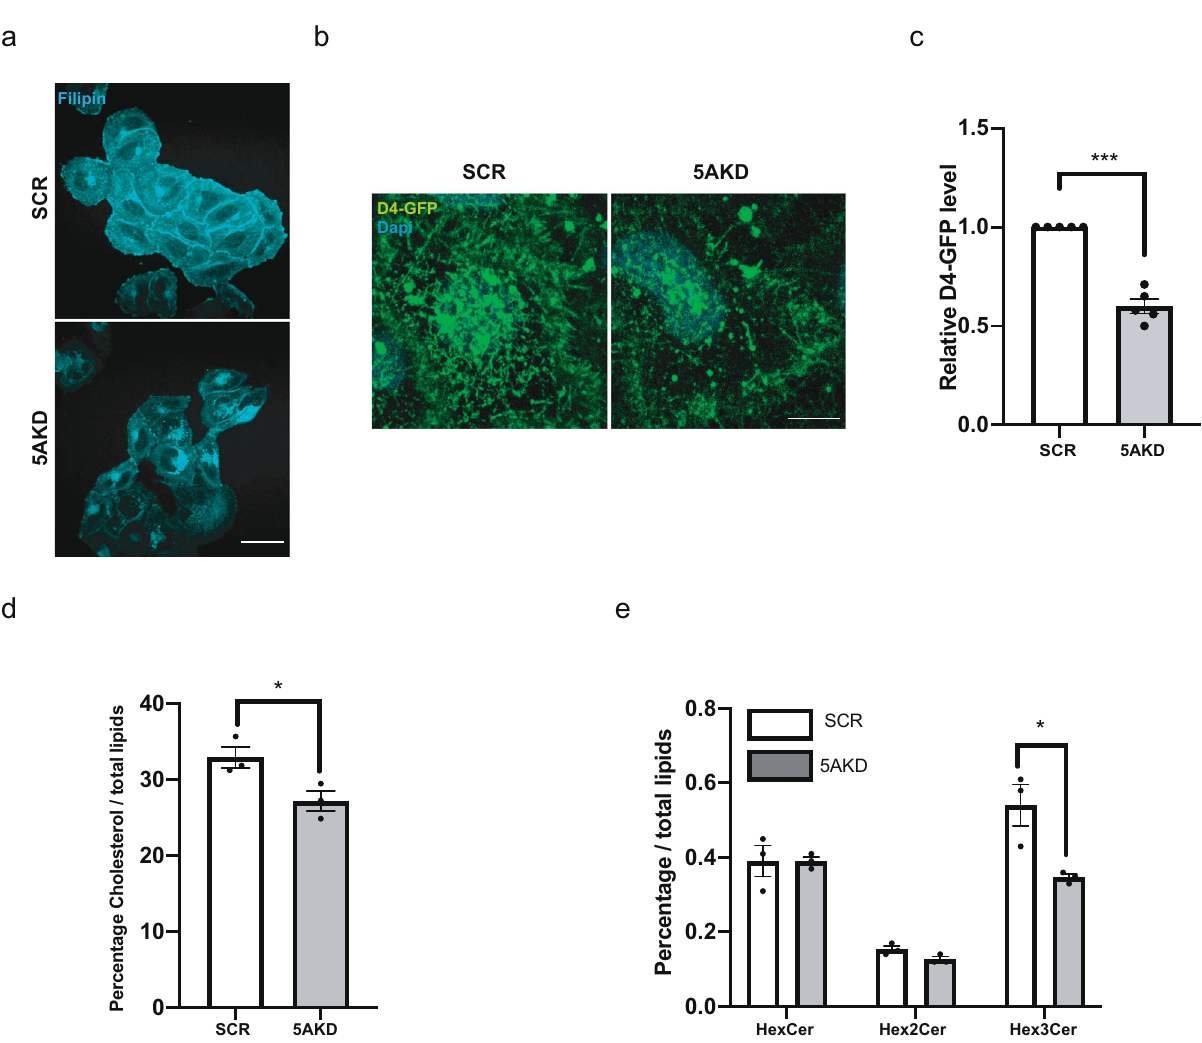
Fig. 3 Cholesterol is partially depleted from the cell surface in the absence of INPP5A. a Representative epi fl uorescent images from four independent experiments of HeLa cells grown in serum-containing media treated with control (SCR) or INPP5A siRNA (5AKD) and incubated for 45 min post- fi xation with 0.05 mg/ml Filipin (cyan). Scale bar, 25 μ m. b Representative z -projections from confocal images of HeLa cells grown in serum-containing media treated with control (SCR) or INPP5A siRNA (5AKD) and stained for plasma membrane cholesterol using recombinant D4-GFP (green). Blue, DAPI- stained nuclei. Scale bar, 10 μ m. c Relative D4-GFP level as a measure for plasma membrane cholesterol in HeLa cells treated with control (SCR) or INPP5A siRNA (5AKD). One sample t -test 5AKD: p = 0.0004, t = 10.97, df = 4. Data represent mean ± SEM from fi ve independent experiments ( d , e ) Lipidomic analysis of plasma membrane-enriched fractions from control (scrambled siRNA, SCR) and INPP5A-depleted (5AKD) HeLa cells grown in serum- containing media. Depicted are free cholesterol, trihexosylceramide (Hex3Cer, i.e., Gb3), dihexosylceramide (Hex2Cer), and hexosylceramide (HexCer). Two sided t -test: Cholesterol: p = 0.0411, t = 2.971, df = 4. Two sided t -test corrected for multiple comparisons using the Holm-Sidak method: HexCer: p > 0.999, t = 0, df = 4. Hex2Cer: p = 0.073, t = 2.412, df = 4. Hex2Cer: p = 0.027, t = 3.43, df = 4. Data represent mean ± SEM from three independent experiments. Numerical source data are reported in the Source Data fi